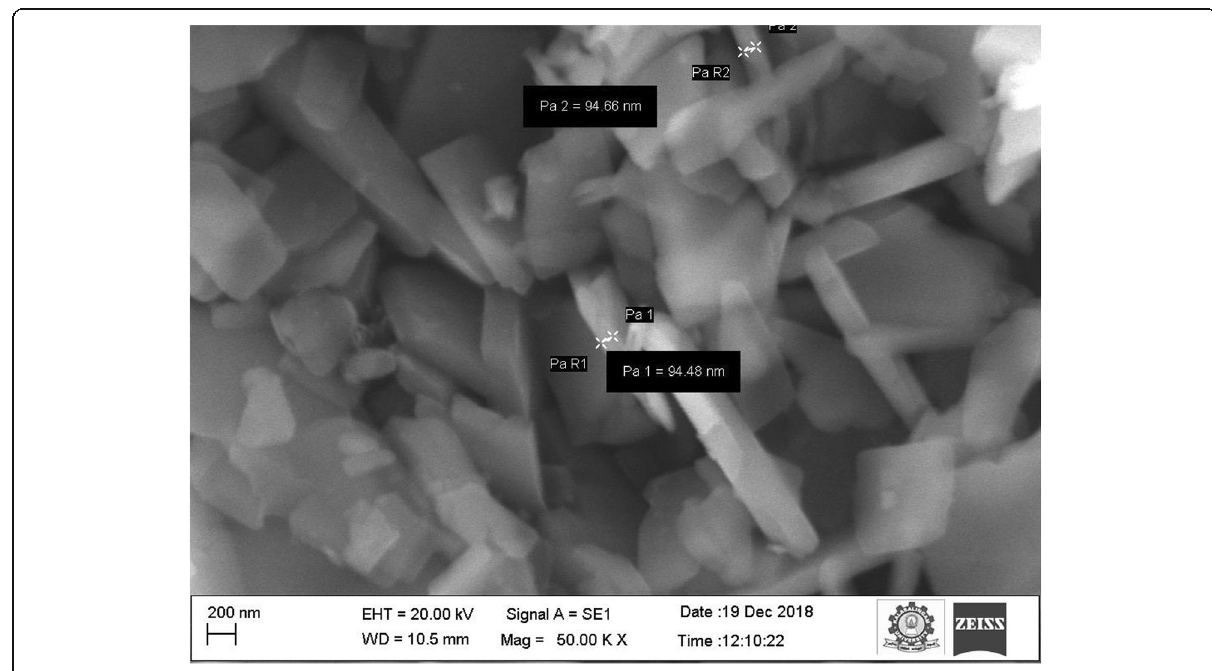
Fig. 9 SEM micrograph of undoped CHPD crystal